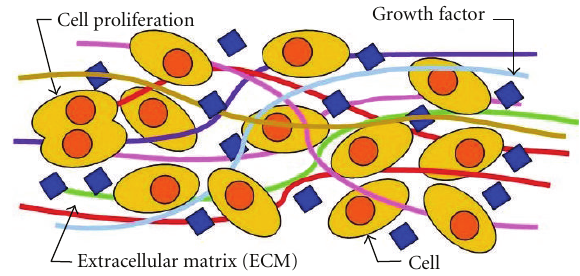
Figure 1: Schematic of the cellular